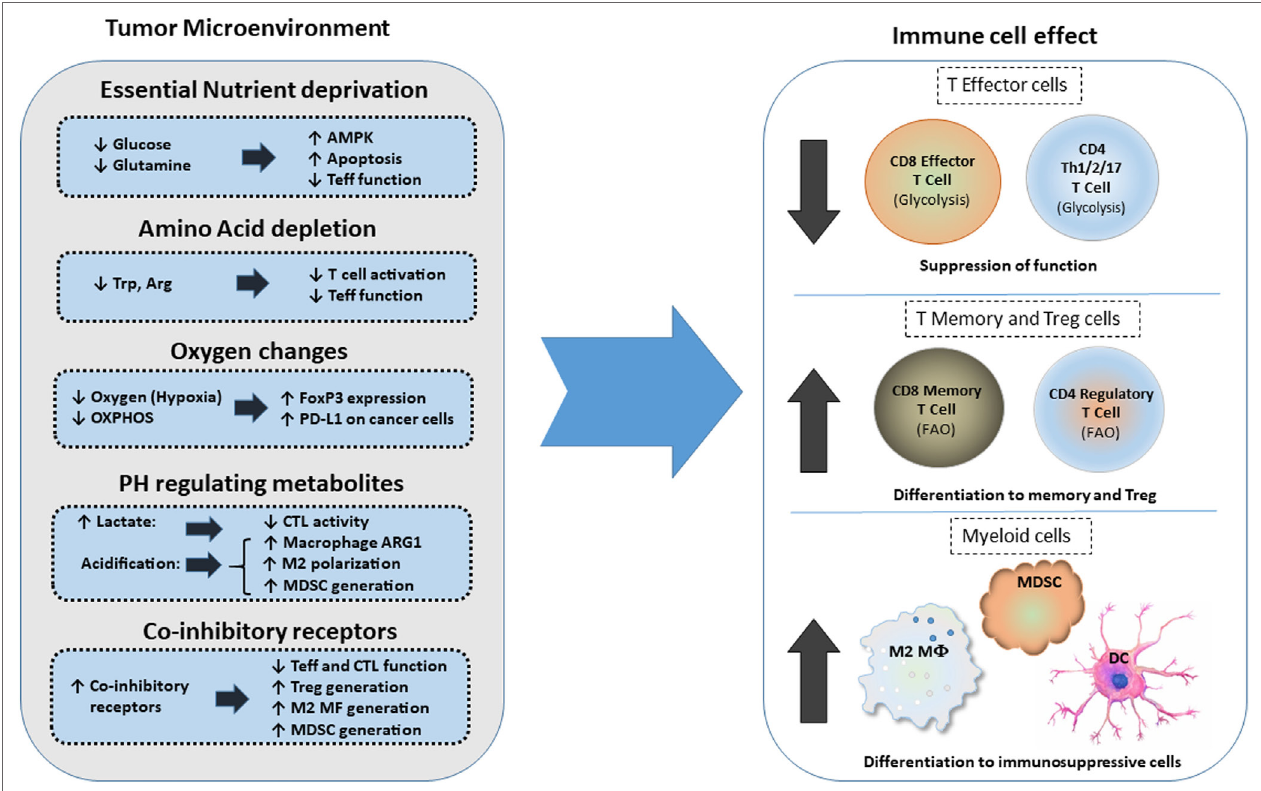
FiGURe 3 | Effects of metabolic changes of the tumor microenvironment (TME) on immune cell differentiation. Metabolic changes of the TME driven by the increased metabolic activity of cancer cells alter the differentiation program of myeloid cells and T cells. In addition, expression of coinhibitory receptors alter signaling and cell-intrinsic metabolic reprogramming thereby limiting T cell cytolytic activity and promoting Treg differentiation and generation of suppressive myeloid cells. Abbreviations: AMPK, AMP-activated protein kinase; Arg, arginine; Arg1, arginase 1; CTL, cytolytic CD8 + T lymphocytes; DC, dendritic cell; FoxP3, forkhead-box P3; M2 MF, alternatively activated macrophage; MDSCs, myeloid-derived suppressor cells; OXPHOS, oxidative phosphorylation; PD-L1, programmed death-ligand 1; Teff, effector T cell; Th, T helper cells; Treg, regulatory T cells; Trp,